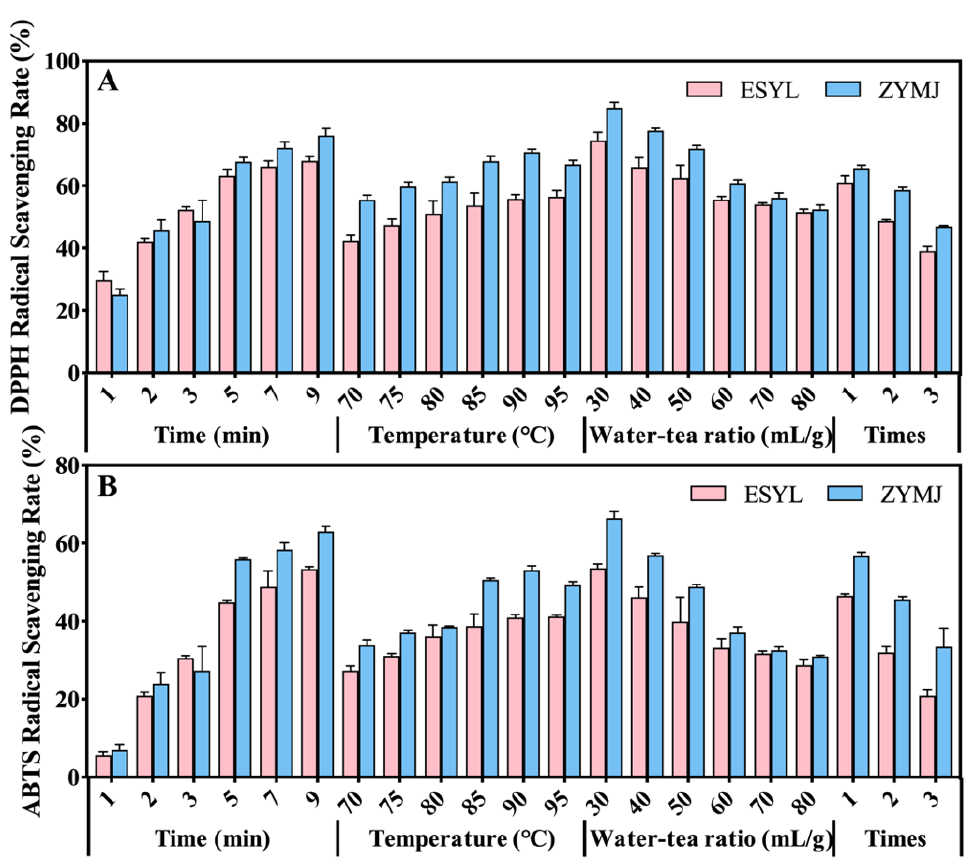
Figure 3. Effects of brewing conditions on the antioxidant activity of tea infusions for ESYL and ZYMJ. The antioxidant activity of green tea infusions determined using DPPH ( A ) and ABTS ( B ) assays. Data are expressed as mean ± SD of the triplicate experiments.